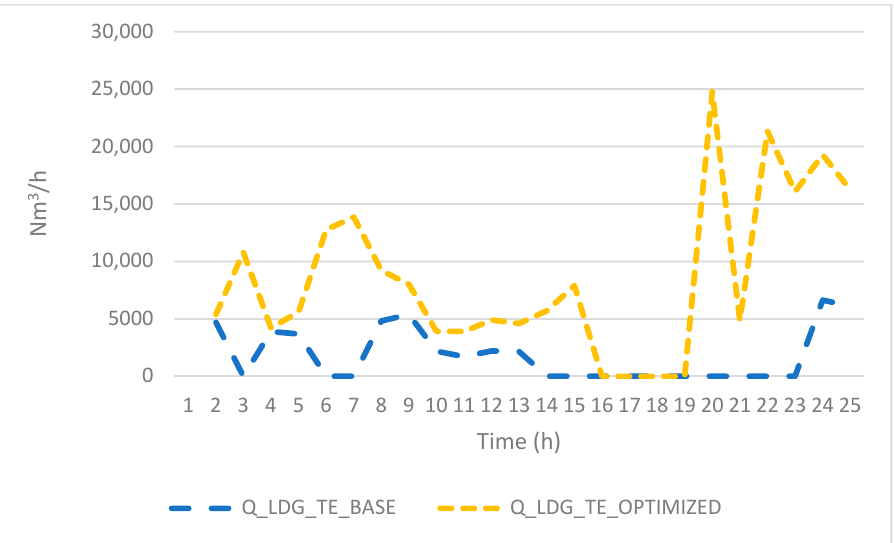
Figure 7. Base and optimized LDG distribution for electricity production in the planning period.